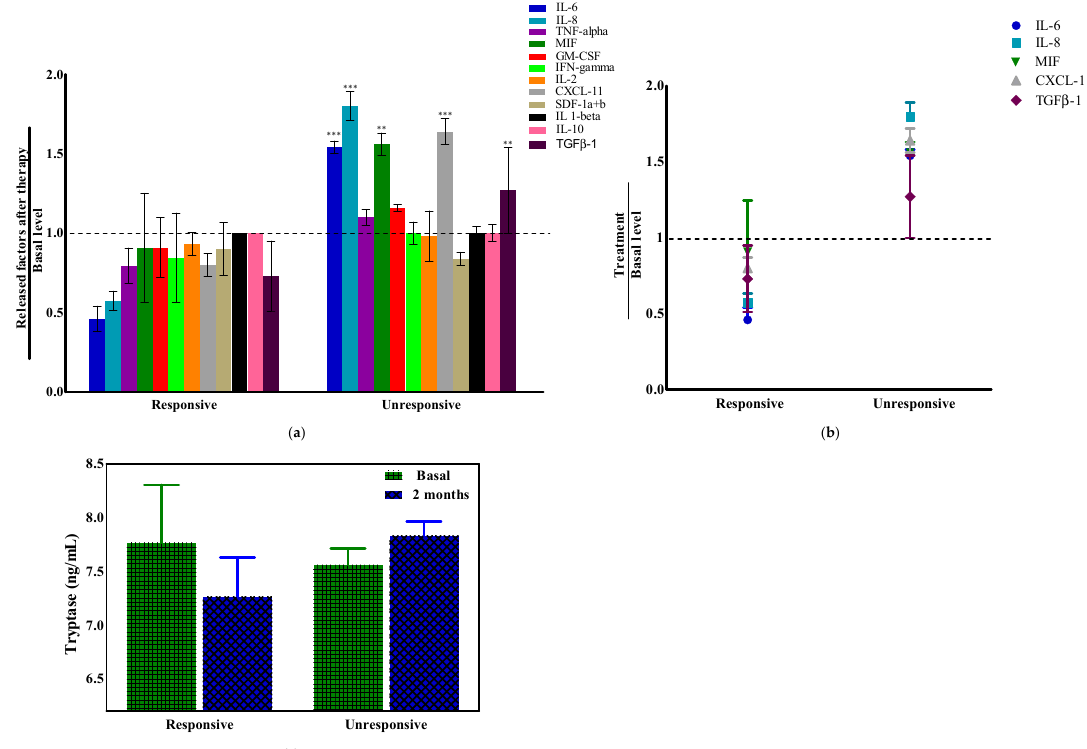
Figure 6. Tryptase and cytokines released in the blood of patients according to response to therapy. The analysis of some mediators released from tumor and stromal cells were measured in plasma or serum samples of 10 advanced pancreatic ductal adenocarcinoma (PDAC) patients. Venous blood was drawn before therapy (baseline) and after 2 months. ( a ) Graph bars report the fold change of cytokines in blood samples in responsive and unresponsive PDAC patients ( b ) the chart reports significantly different cytokine levels among the groups of patients. Statistical significance has been calculated using a two-way analysis of variance (ANOVA) followed by the Bonferroni post hoc tests (GraphPad Prism vers. 5). Data were indicated with ** p < 0.01, and *** p < 0.001. ( c ) Graph bars reports plasma levels of tryptase in PDAC patients.